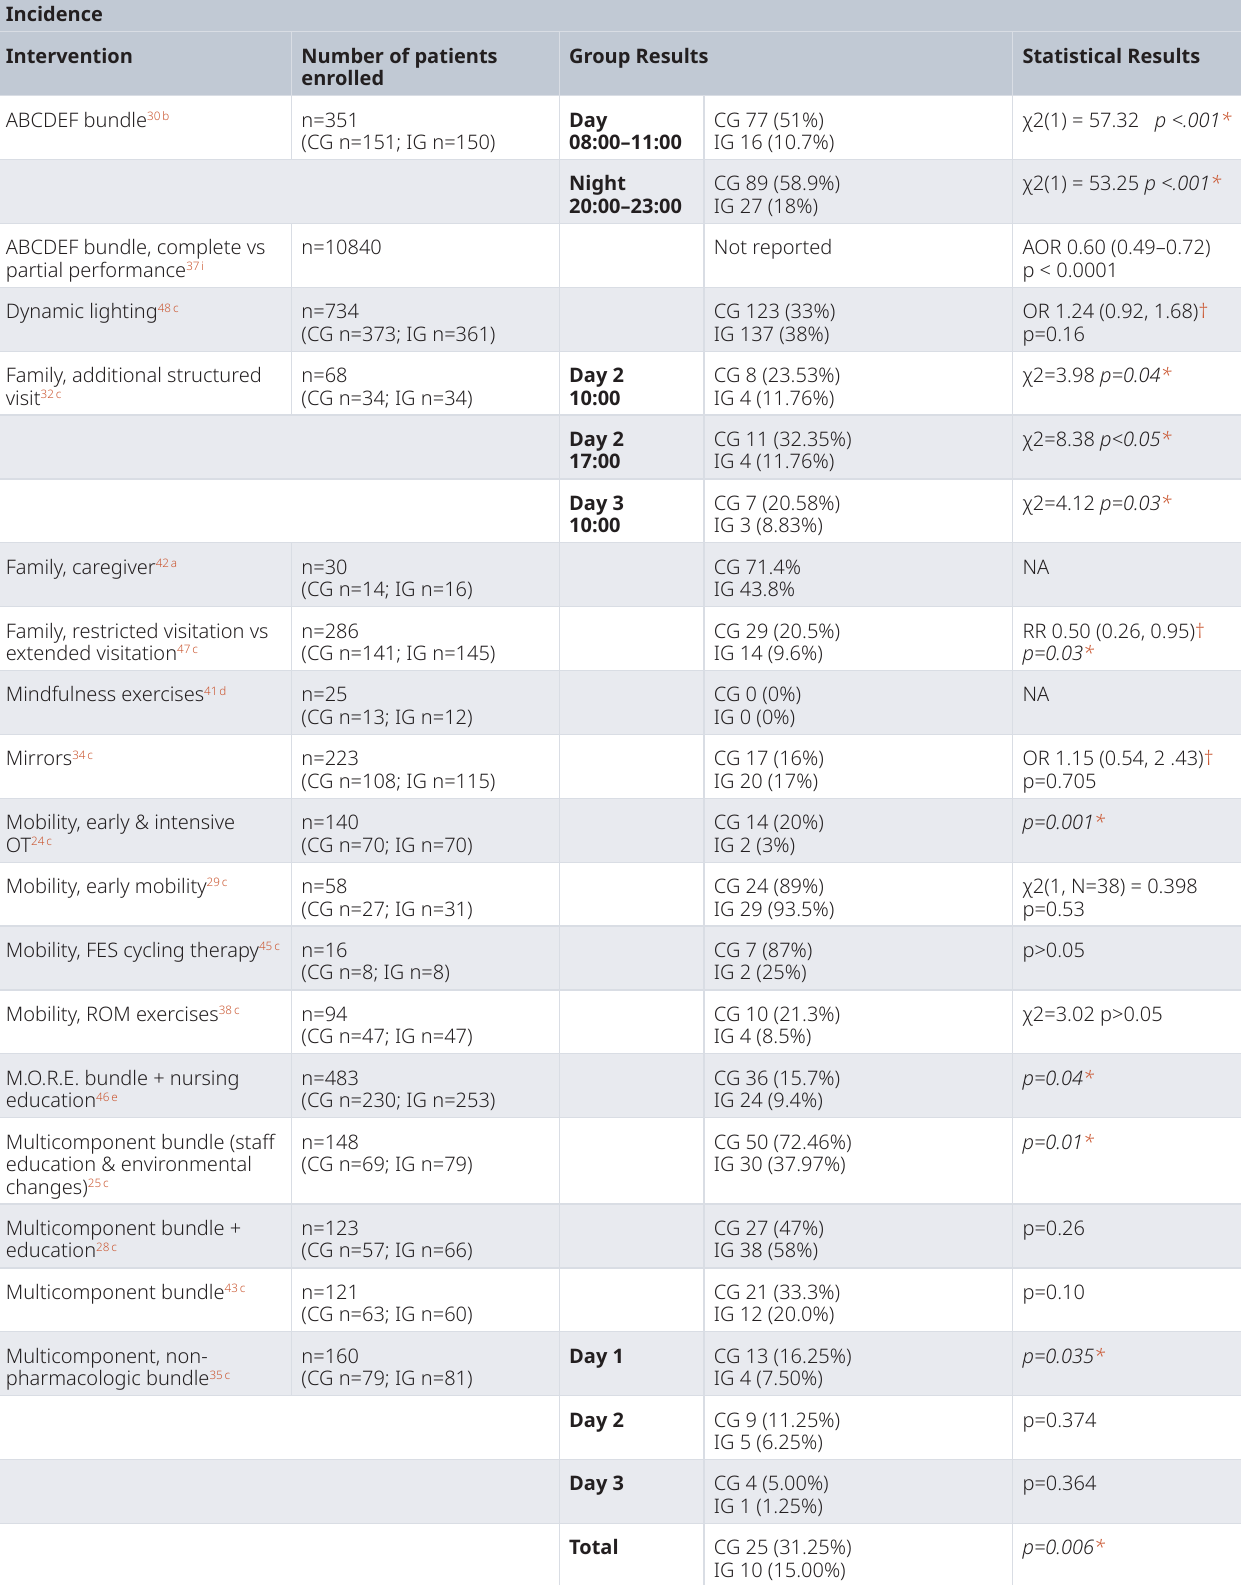
Table 3. Results on incidence and prevalence of delirium. Incidence Intervention Number of patients Group Results Statistical enrolled